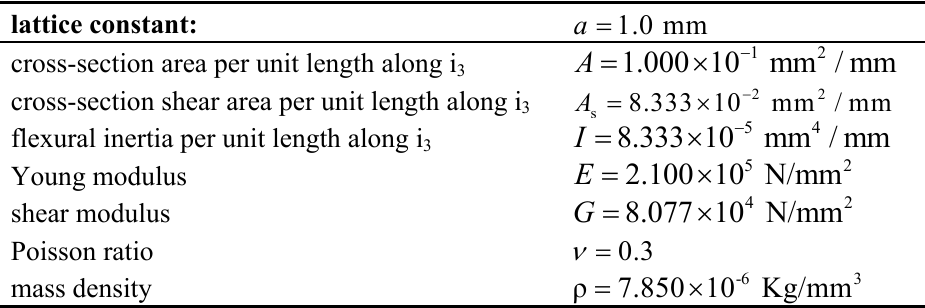
Table 1. Geometry and mechanical